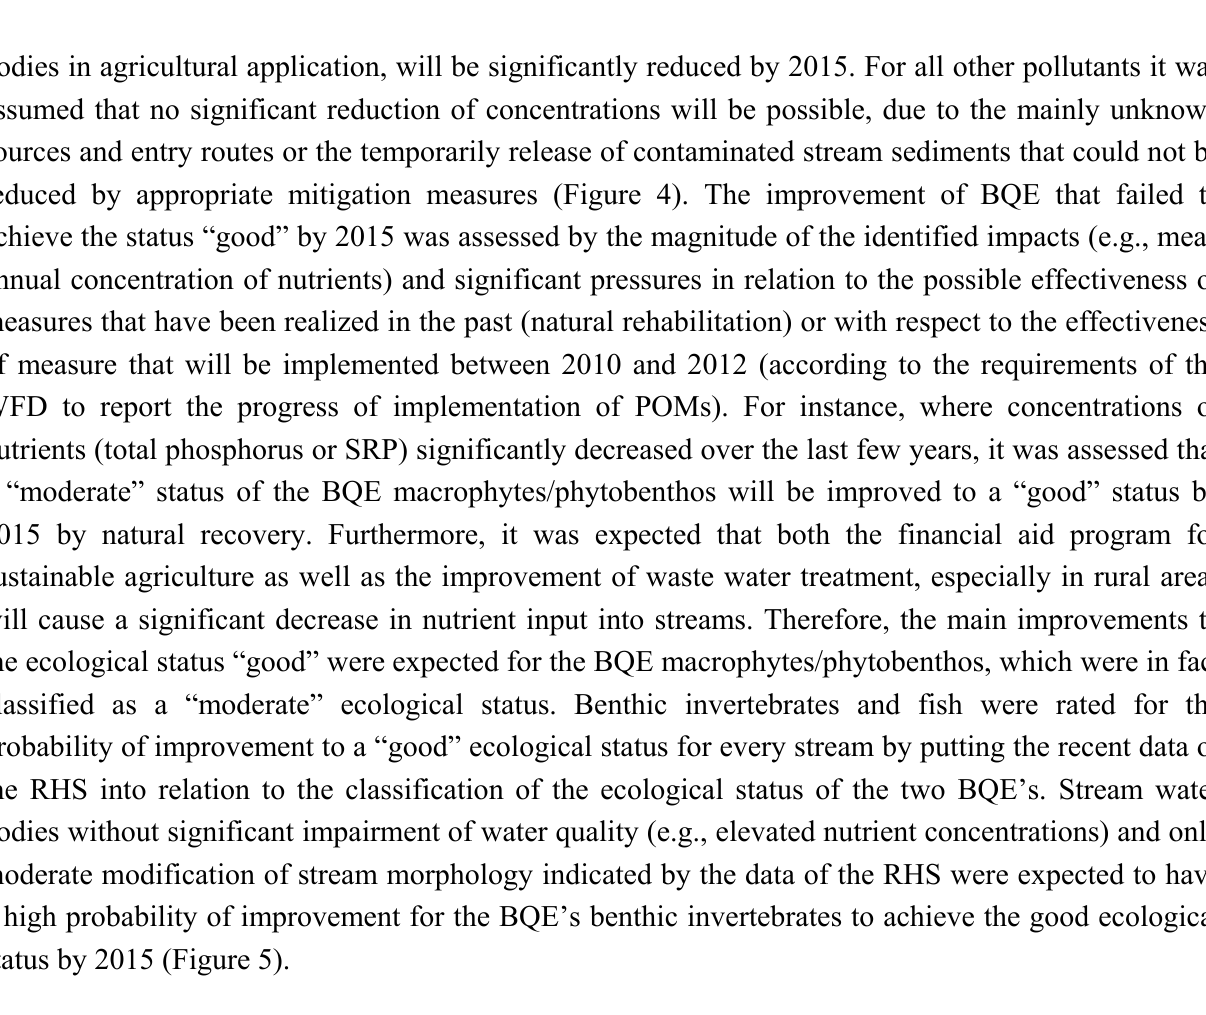
Figure 5. Prospects of improvement for all biological quality elements (BQE) and specific synthetic and non-synthetic